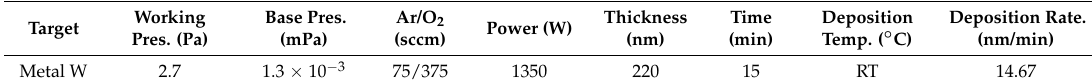
Table 2. Deposition parameters of the WO 3 electrode film.